Question: How would you classify this visualization?
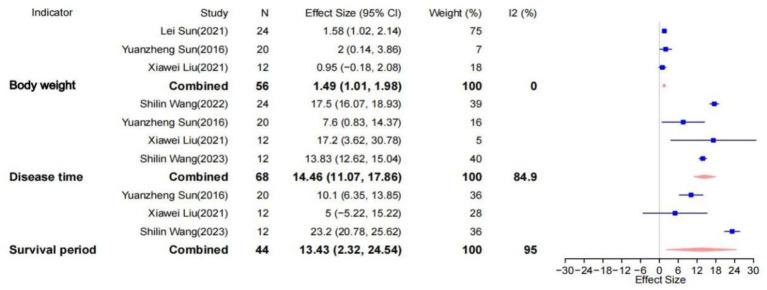
Answer: forest